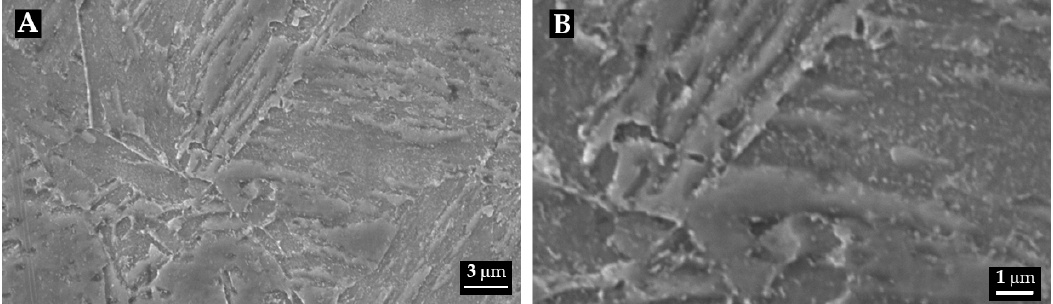
Figure 5. SEM micrographs of the sample quenched and tempered at 590 °C for 6 h at low magnification ( A ) and higher magnification ( B ).